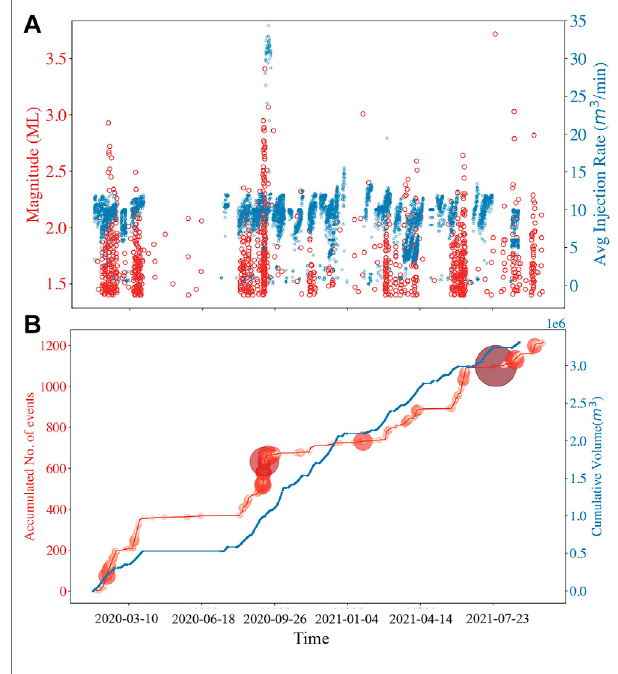
FIGURE 2 | (A) Red circles show the magnitudes (ML) of the events in the full catalog from January 22, 2020 to September 30, 2021. Only events above magnitude of completeness are shown here. Blue circles show the average daily injection rate from January 21, 2020 to August 28, 2021 due to hydraulic fracturing. From March 30 to July 14 of 2020, there are no fl uid injections due to the COVID-19 lockdown, yet there are still events being recorded. (B) Red line indicates the accumulated number of events above magnitudeofcompleteness. Theradius oftheredcircles isproportionaltothe magnitude of the induced events. The blue line shows the accumulated amount of injection volume to the KSMMA from January 21, 2020 to August 28, 2021 due to hydraulic fracturing. (Injection Data provided by geoLOGIC systems ltd. ⓒ